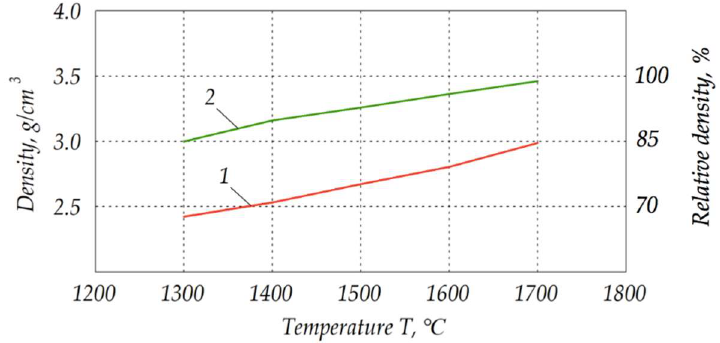
Figure 12. Density of the tested composites Al 2 O 3 —20 wt.% SiO 2 —10 wt.% ZrO 2 prepared at different temperatures: 1 —by traditional sintering method, 2 —by electroconsolidation.